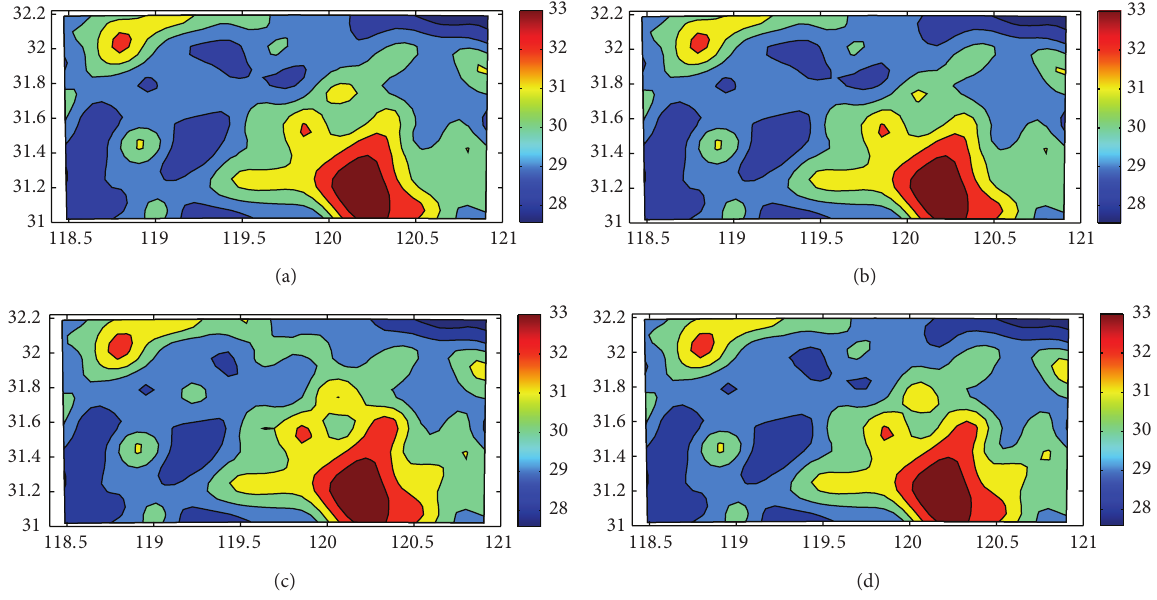
Figure 7: Spatial pattern of the monthly average temperature in Southern-Jiangsu in July under different scenarios (unit: ∘ C). (a) and (b) show the simulation result of monthly average temperature in Southern-Jiangsu in July of land use in year 2010 under REG scenario and CES scenario, respectively; (c) and (d) show the simulation result of monthly average temperature in Southern-Jiangsu in July of land use in year 2050 under REG scenario and CES scenario,